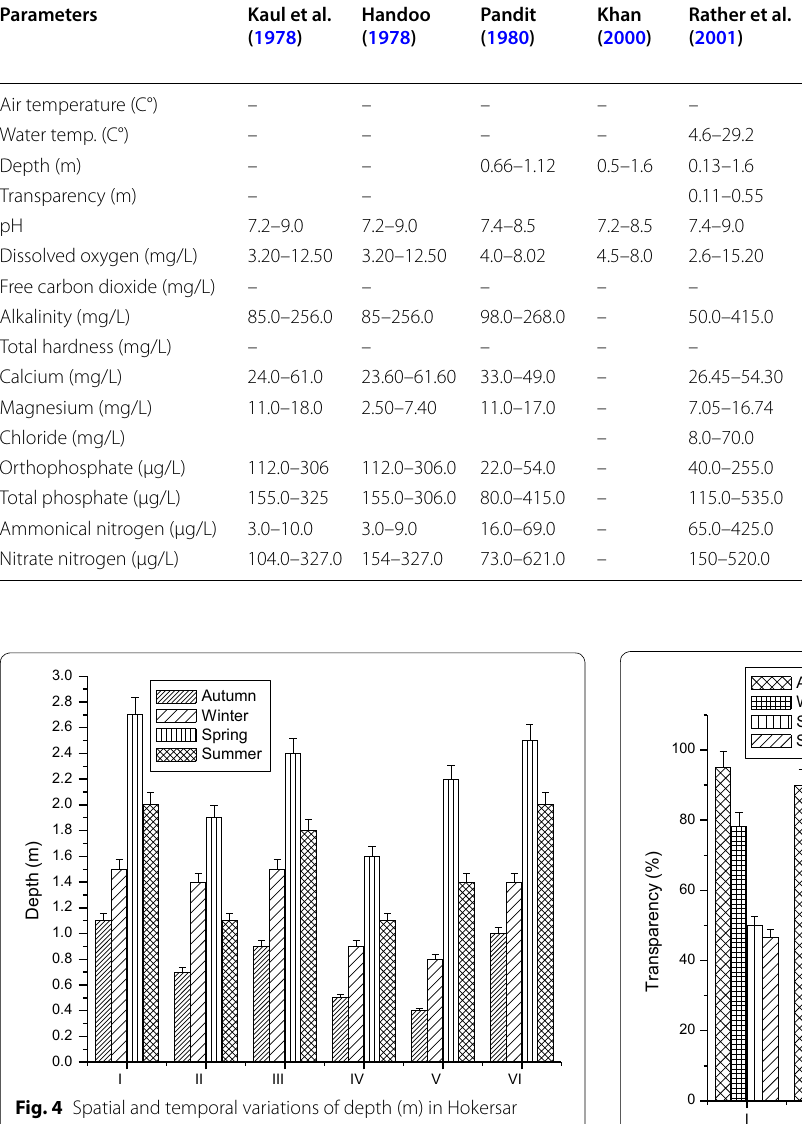
Table 1 Range of various physico-chemical parameters of Hokersar wetland from 1978 to 2012–2013